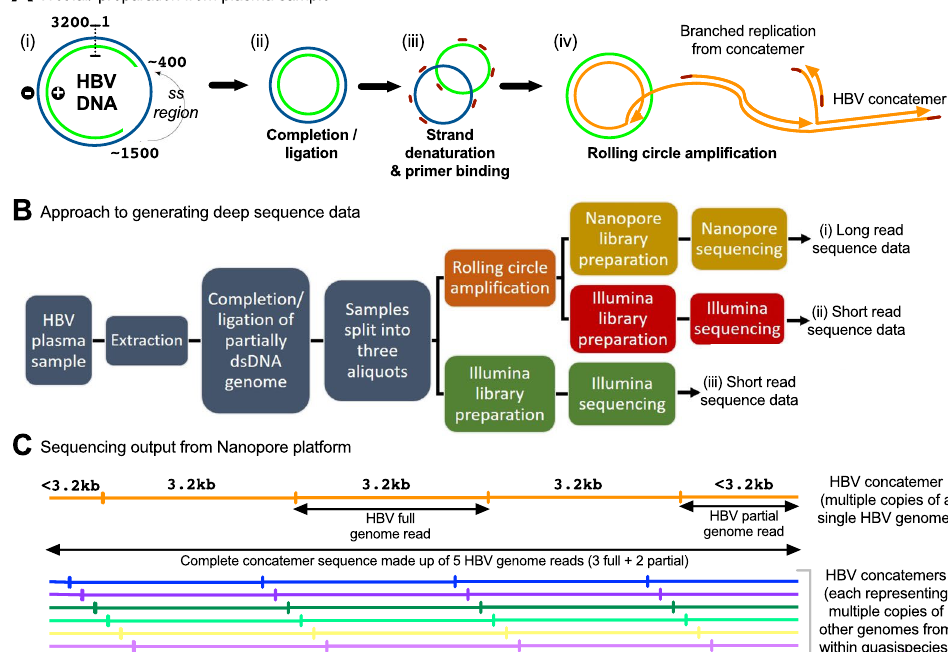
Figure 1. Schematic diagrams to show the pipeline for HBV sample processing. ( A ) (i) HBV genomes comprise partially double-stranded DNA in human plasma samples; (ii) completion-ligation (CL) derives a completely double-stranded DNA molecule; (iii) the complete dsDNA molecule is denatured and primers (red) bind; (iv) rolling circle amplification (RCA) generates genome concatemers, containing multiple end-to-end copies of the HBV genome (shown in orange). Amplification may also arise de novo due to priming along the length of the concatemer, creating a branched structure (primers shown in red). ( B ) Flow diagram to illustrate sample processing from from plasma through to HBV genome sequencing on Nanopore (yellow) and Illumina (red and green) platforms. This work flow allowed us to undertake a comparison between data derived from Illumina sequencing with RCA vs. without RCA, and comparison of RCA followed by sequencing using Illumina vs. Nanopore. Comparison of Nanopore with RCA vs. without RCA was not possible due to the requirement for amplification of HBV DNA prior to Nanopore sequencing (as shown in Table 2). ( C ) The sequence dataset derived from Nanopore comprises concatemeric reads comprising multiple reads of the same HBV genome (shown in orange). As indicated, concatemers containing three full length genomes also contain first and last segments that are partial ( < 3.2 kb). Other HBV genomes from among the quasispecies are represented by other individual concatemers (shown in blue, green,